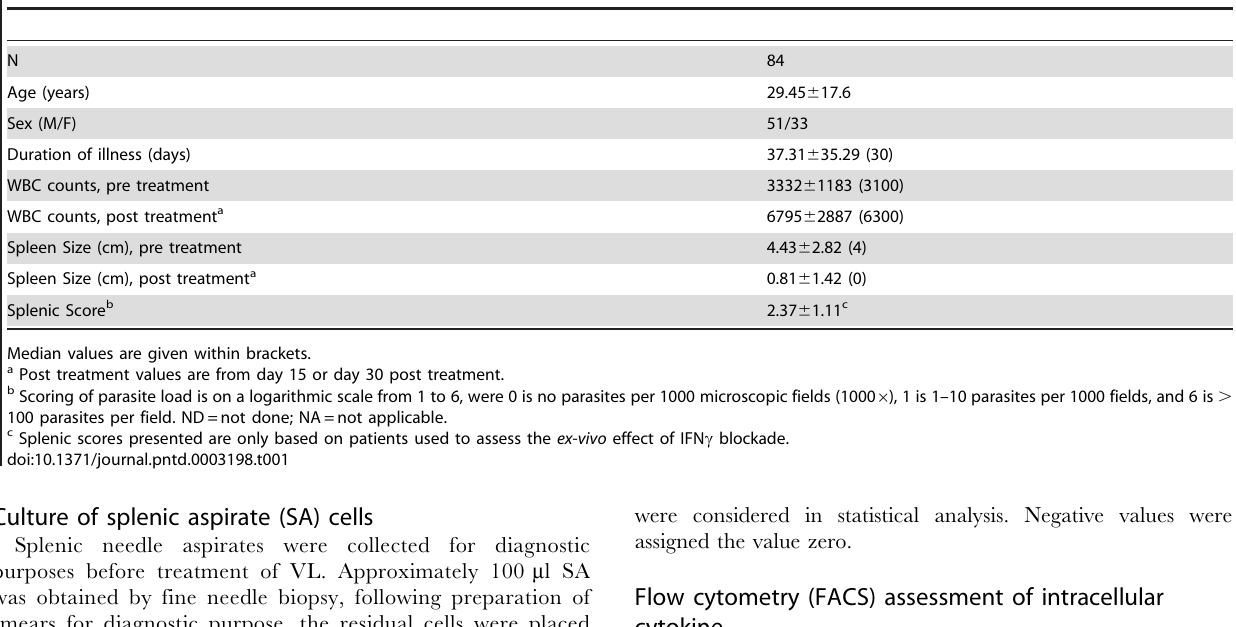
Table 1. Aggregate clinical data for VL